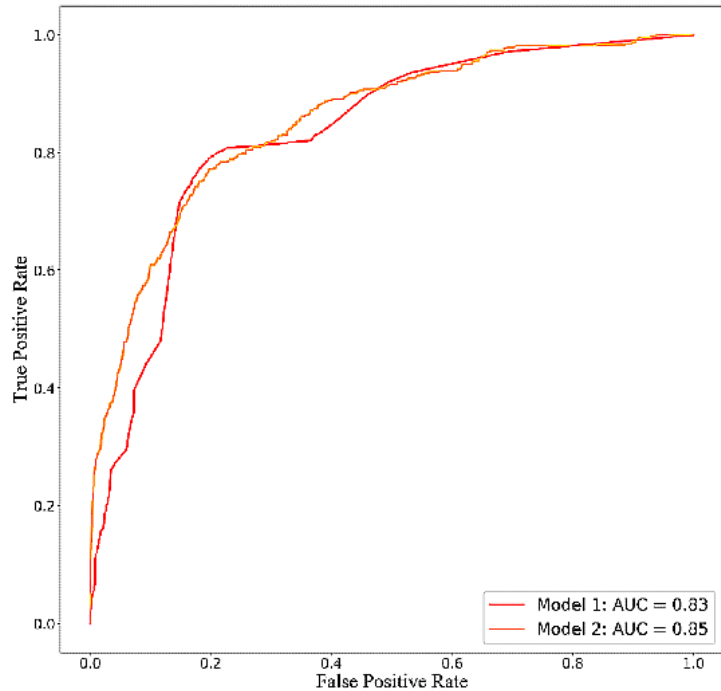
Figure 2. Receiver-operating characteristic curves of model 1 and model 2. AUC: the area under the curve.